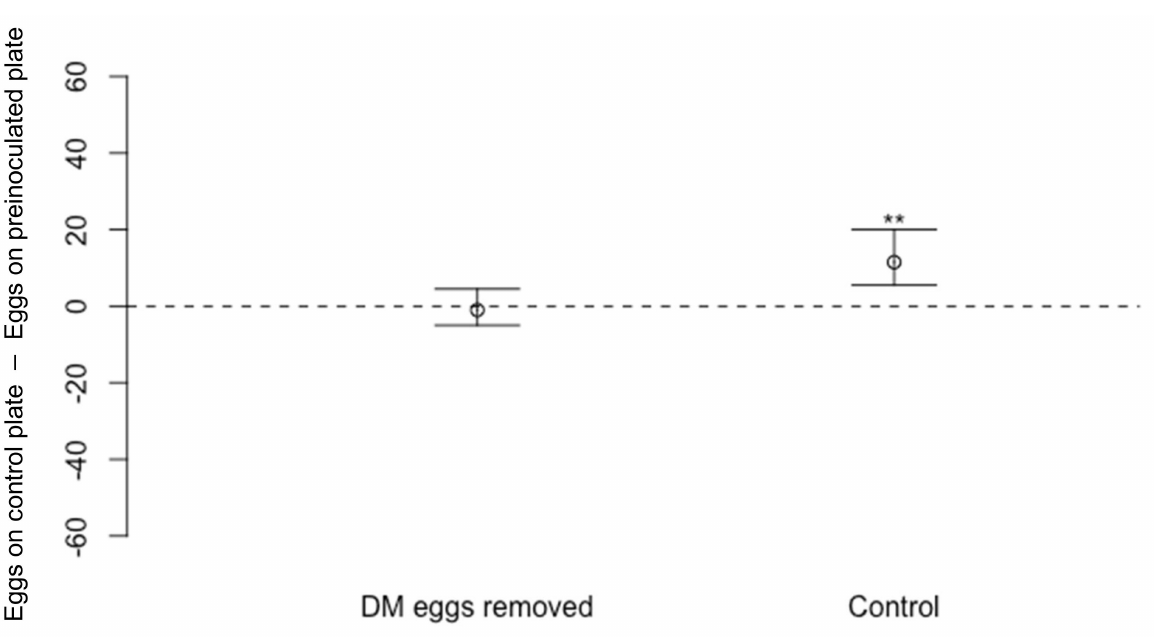
Figure 6. Differences in numbers of eggs laid by Drosophila suzukii (Median ± 95% confidence intervals) laid on cornmeal media dishes where D. melanogaster (DM) females were allowed to lay eggs in which the eggs were then removed compared to D. suzukii eggs laid on a blank dish ( n = 20, p = 0.64). In the control experiment, fewer eggs were laid by D. suzukii on cornmeal media dishes pre-exposed to D. melanogaster compared to those on blank, unexposed dish ( n = 20, p < 0.01 **).